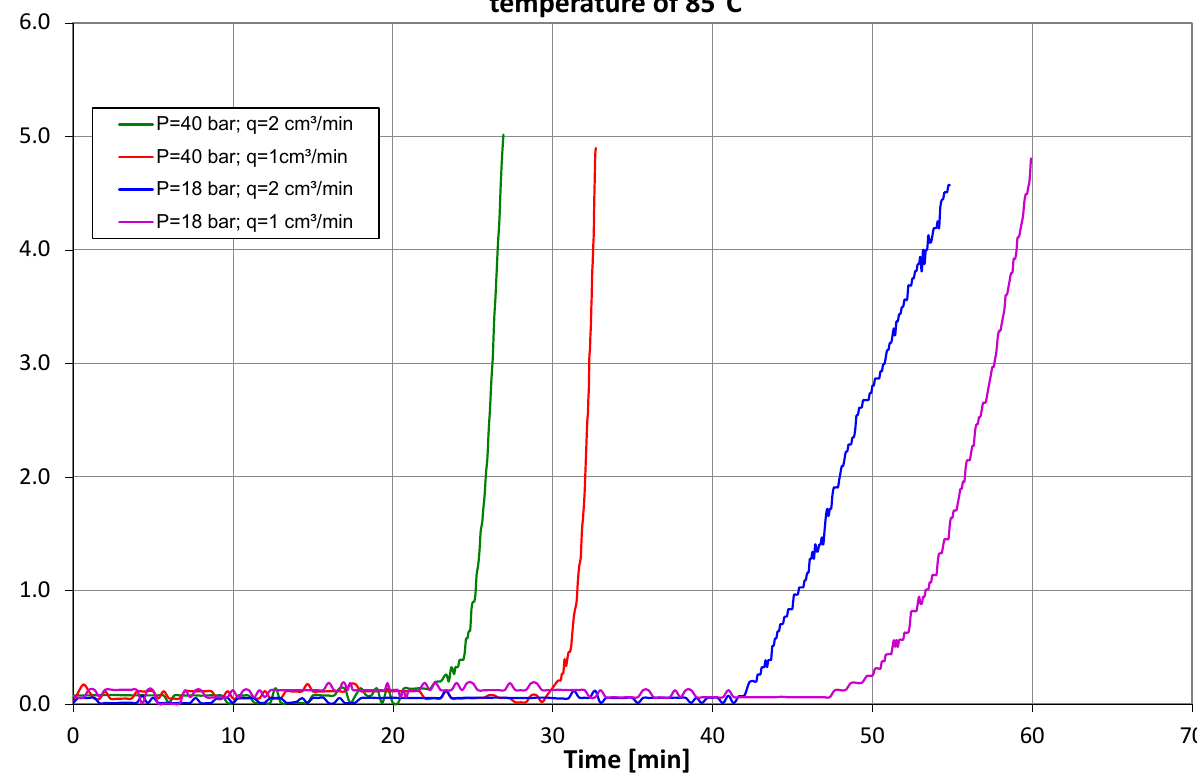
Figure 4. Tests for the precipitation of sediments for water “A” modified with sodium bicarbonate (2 g/800 mL) and water “B” at a temperature of 85 °C (measurement error is ±4%).